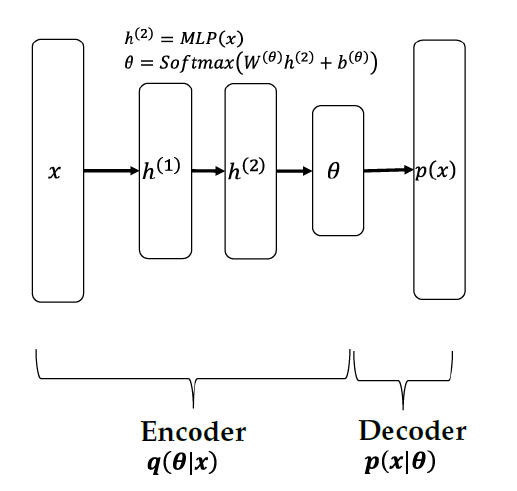
Figure 3. Representation of the model based on